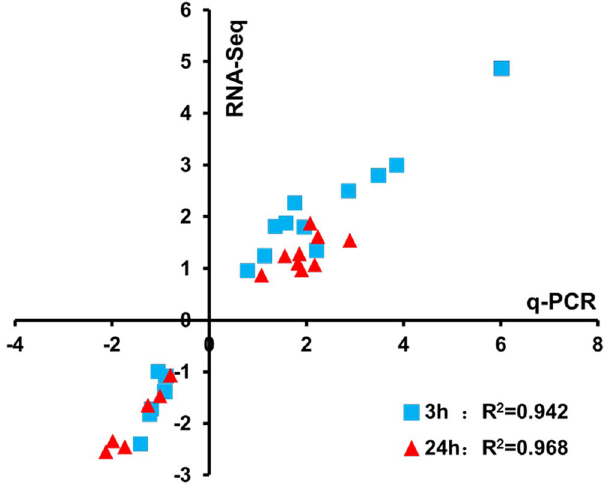
Figure 3. Correlation between RNA-Seq and real-time qRT-PCR results for RNA-Seq data verification. The gene expression ratios of both RNA-Seq data and qPCR data were log transformed in base 2 (log 2 < Ethanol_ treatment/Control > ), and RNA-Seq log 2 ratio values were plotted against the qRT-PCR log 2 values. Twenty four genes tested are glnP (LBAT_0325), glnP (LBAT_0326), glnQ , mpg , gltP , dck , adhE , groEL , pyrR